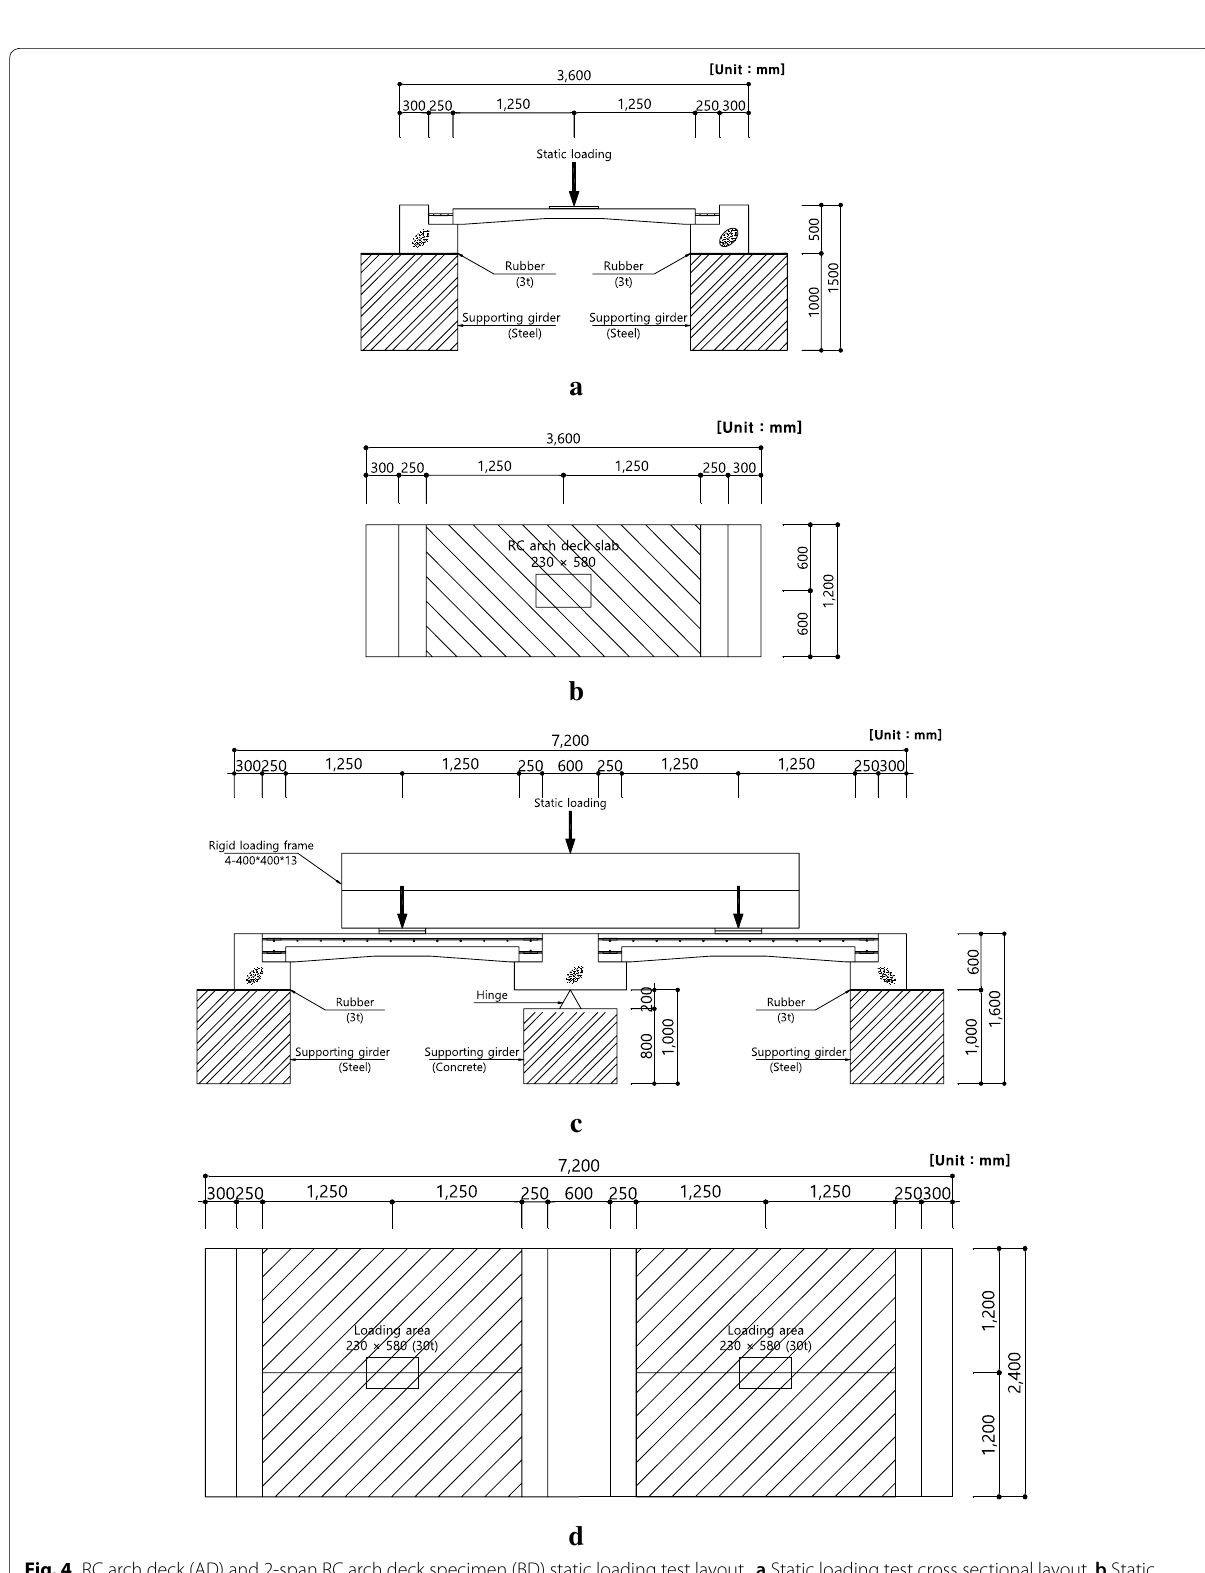
Fig. 4 RC arch deck (AD) and 2‑span RC arch deck specimen (BD) static loading test layout. a Static loading test cross sectional layout. b Static loading test plane layout. c Static loading test cross sectional layout. d Static loading test plane